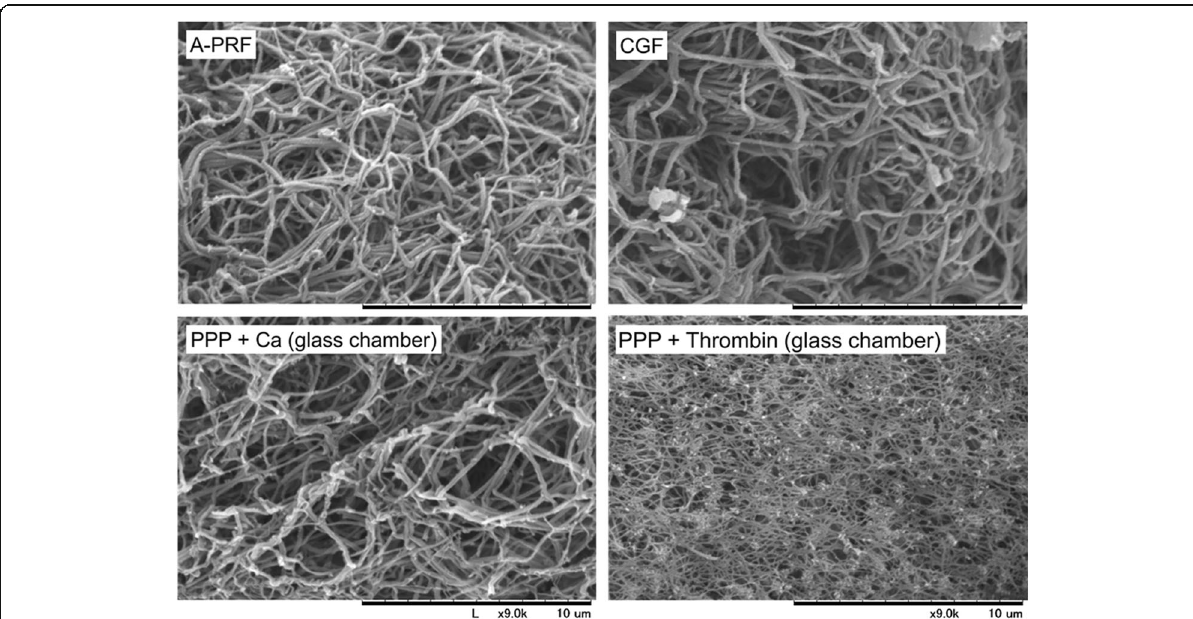
Fig. 1 Surface microstructures of A-PRF, CGF, and fibrin clots prepared by PPP+CaCl 2 and PPTF (fibrin clots prepared by PPP and thrombin). Similar observations were obtained from other three independent blood samples. Scale bar =10 μ m. Note : the same magnification (×9000) was used in all the SEM images shown here